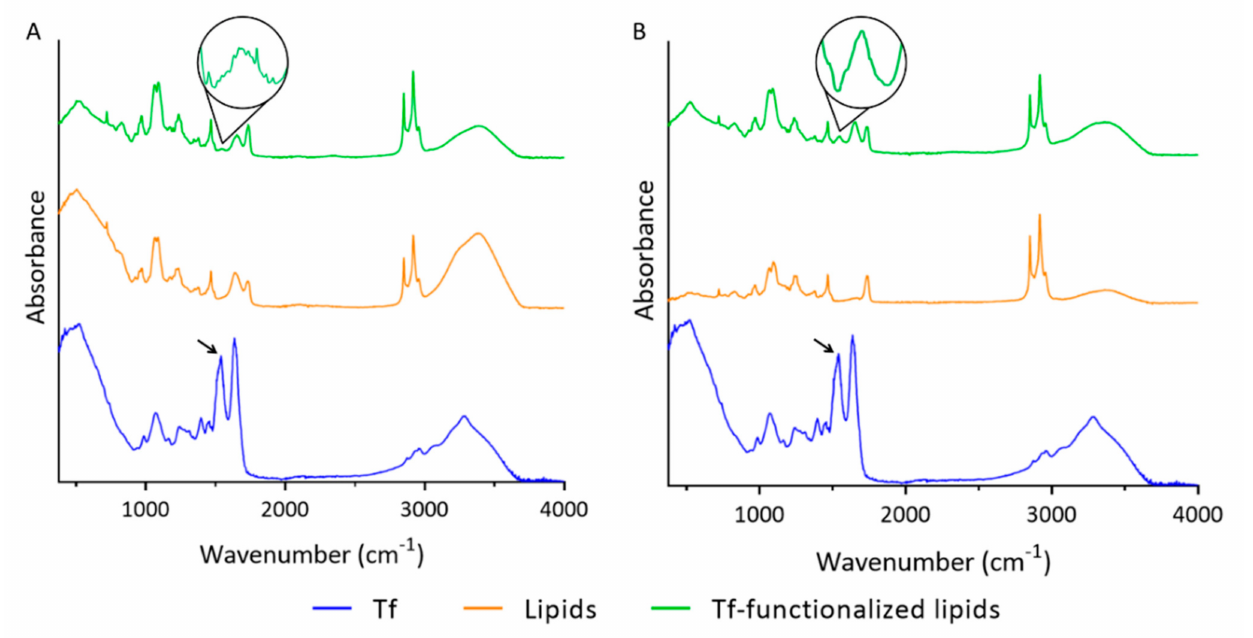
Figure 3. ATR-FTIR spectra of Tf (blue line), non-functionalized lipids (orange line), and Tf- function- alized lipids (green line) in the ( A ) absence and ( B ) presence of GA. Black arrow represents the amino II peak at 1540 cm − 1